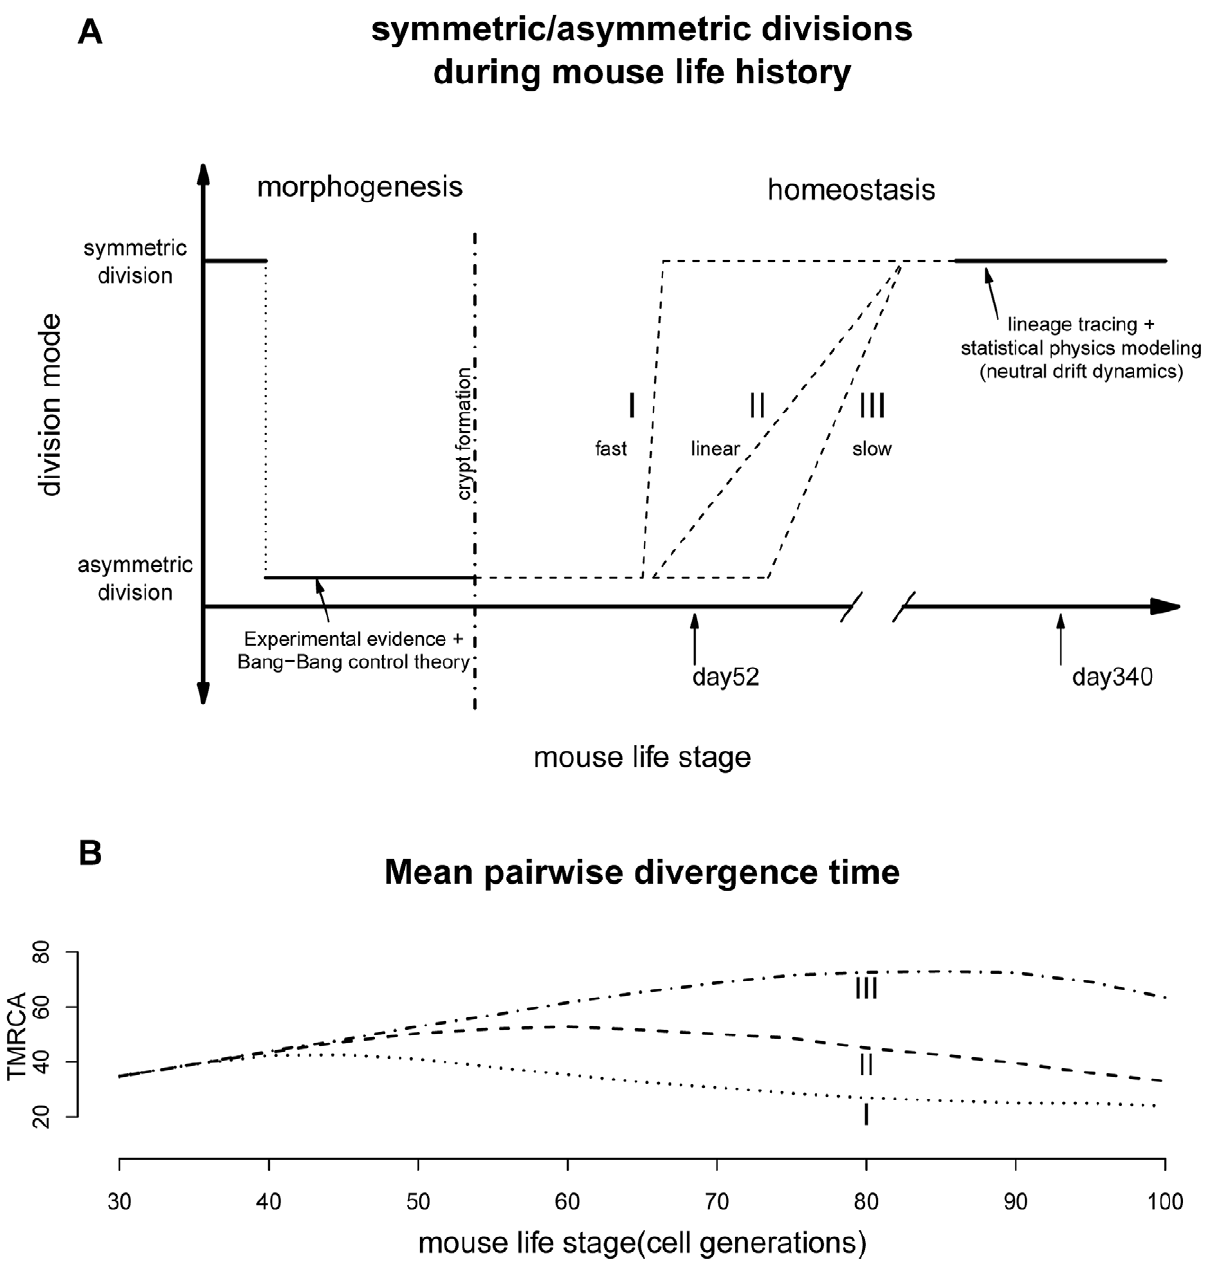
Figure 3. Lifelong equilibrium for stem cell symmetric/asymmetric divisions. (A) The proportion of asymmetric and symmetric division as a function of mouse life stage. The pattern from morphogenesis are from experimental data together with the optimal control theory prediction [25]. The lineage tracing evidences are from two earlier studies [23,24]. The transition from cell asymmetry to population asymmetry can take a variety of forms, including I) a fast switch similar to the Bang-Bang control, II) a linear accumulation, III) slow progression depending on the interplay between intrinsic and extrinsic signals. (B) When simulating crypt histories using curve I, II and III in Figure 3A and plotting mean pairwise divergence time between two random cells (a measurement of genealogical length), the average pairwise divergence shows very different trajectories under different transitional history.